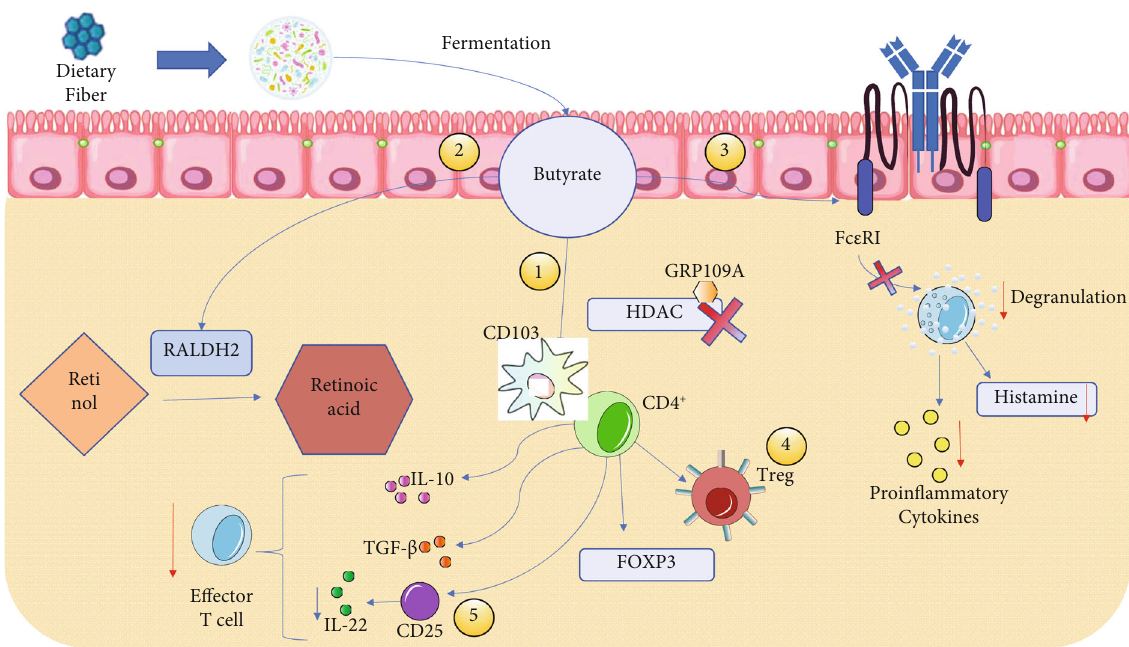
Figure 2: Intestinal microbiota immunological mechanism against FA. 1: inhibits HDAC through the GRP109A receptor, acting on CD103 and promoting Treg di ff erentiation; 2: induces RALPH activity, also acting on CD103; 3: inhibits the Fc ε RI receptor, decreasing degranulation and thereby the expression of proin fl ammatory cytokines; 4: Treg expresses FOXP3 and synthesizes inhibitory cytokines such as IL-10 and TGF- β ; 5: CD25, expressed by Treg FOXP3, is capable of decreasing e ff ector T cell proliferation. All these mechanisms contribute to microbiota homeostasis and the gaining of